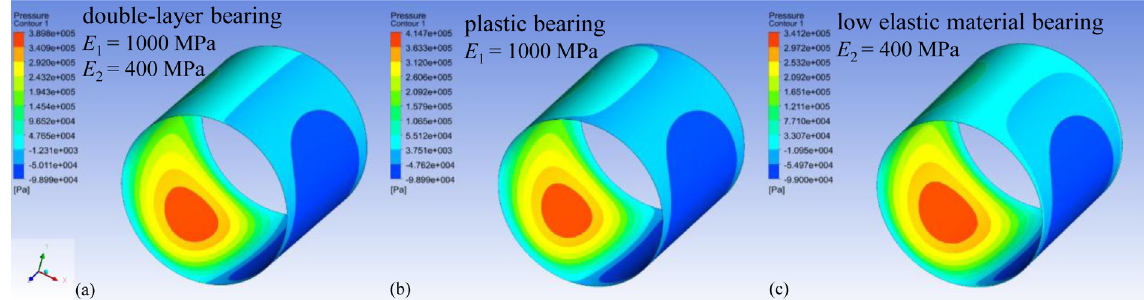
Fig. 5. The water fi lm pressure distribution contour of (a) Double-layer bearing, (b) Plastic bearing, and (c) Low elastic material bearing for e = 0.6, N = 1500rpm.